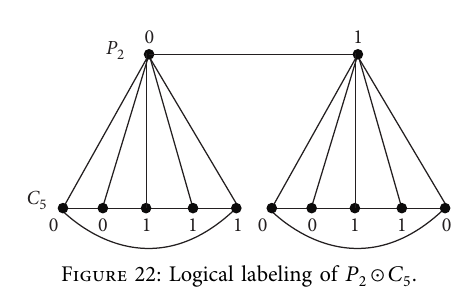
Figure 22: Logical labeling of P